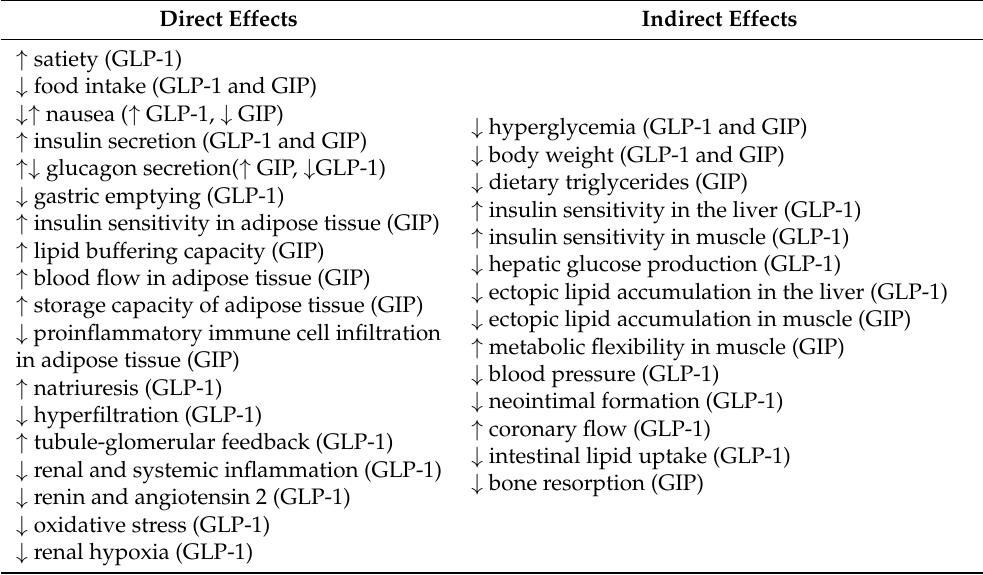
Table 1. Direct and indirect effects of the glucose-dependent insulinotropic polypeptide (GIP) and glucagon-like peptide-1